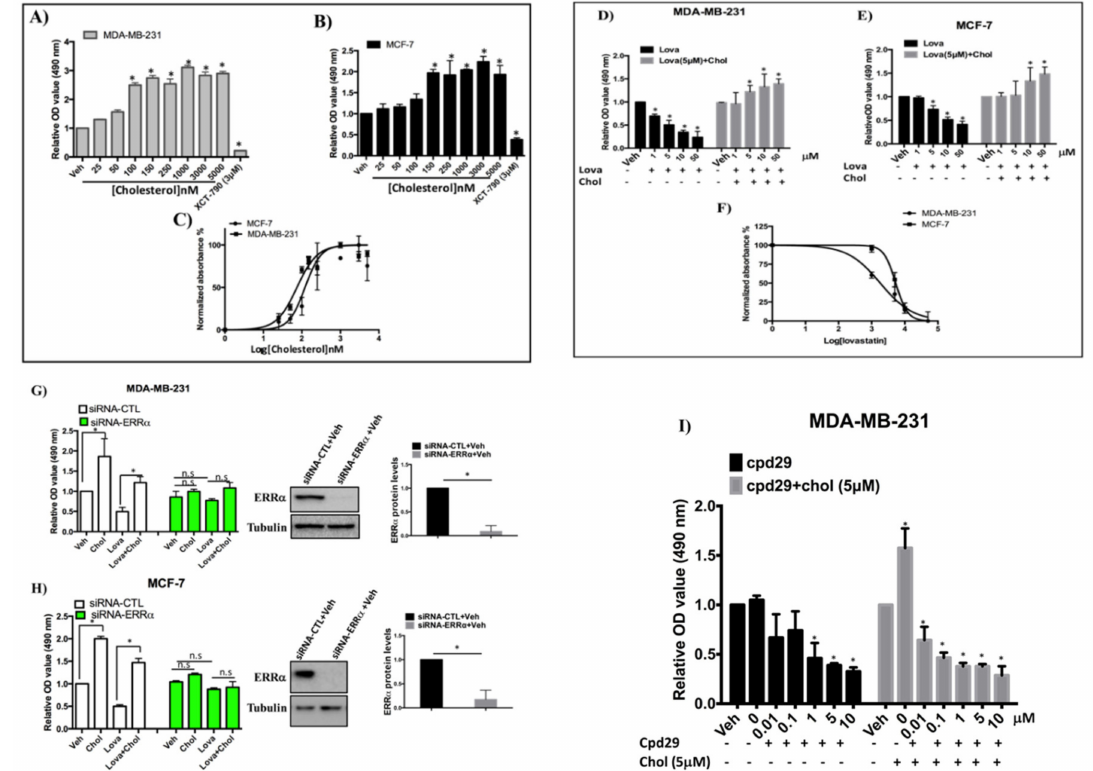
Figure 5. Cholesterol increases cell proliferation of breast cancer cells in an ERR α -dependent manner. ( A , B ) In order to obtain half maximal e ff ective concentrations (EC 50s ) of cholesterol in MDA-MB-231 and MCF-7 cells, an MTS Cell Proliferation Assay kit was used to assay the cell proliferation of MDA-MB-231 and MCF-7 cells with varying concentrations of cholesterol (as indicated in the Figure) on day 5. ( C ) EC50s were calculated for both MDA-MB-231 and MCF-7 cells using the Prism software. ( D , E ) Cell proliferation in the presence of Lovastatin (Lova) and lovastatin (5 µ M) + cholesterol (Chol), at varying concentrations indicated in the Figure, was measured using an MTS kit on day 5. ( F ) IC50s of lovastatin were calculated for both MDA-MB-231 and MCF-7 cells using Prism. ( G , H ) MDA-MB-231 and MCF-7 cells were transfected with siRNA-ERR α or siRNA-control (siRNA-CTL) and the cells were treated with vehicle, cholesterol (chol), lovastatin (lova) or lovastatin + cholesterol (lova + chol), all at 5 µ M for MDA-MB-231 cells and at 10 µ M for MCF-7 cells. Cell proliferation assays were performed using an MTS kit on day 5. Cell lysates were immunoblotted using an anti-ERR α antibody. A value of p < 0.05 was considered significant (*). ( I ) MDA-MB-231 cells were treated with compound 29 (cpd29) in varying concentrations as indicated in the figure (black bars). Also, cholesterol at a fixed concentration of 5 µ M was co-administered with varying concentrations of cpd29 as indicated in the figure (gray bars); 0 indicates cholesterol (5 µ M) alone, without cpd29 treatment. Cell proliferation assays were performed using an MTS kit on day 6. A minimum of three independent experiments were performed. All treatments were compared to the respective vehicle group, and a value of p < 0.05 was considered significant